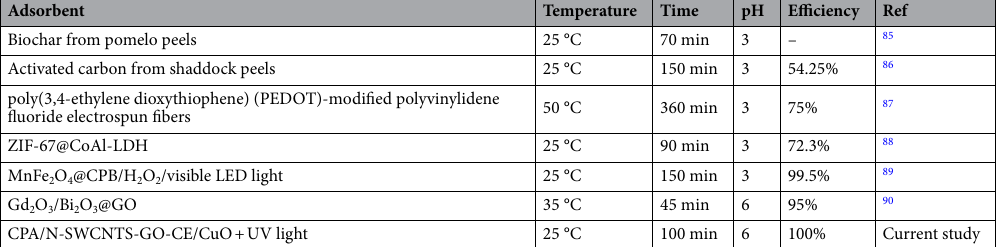
Adsorbent Temperature Time pH Efficiency Ref Biochar from pomelo